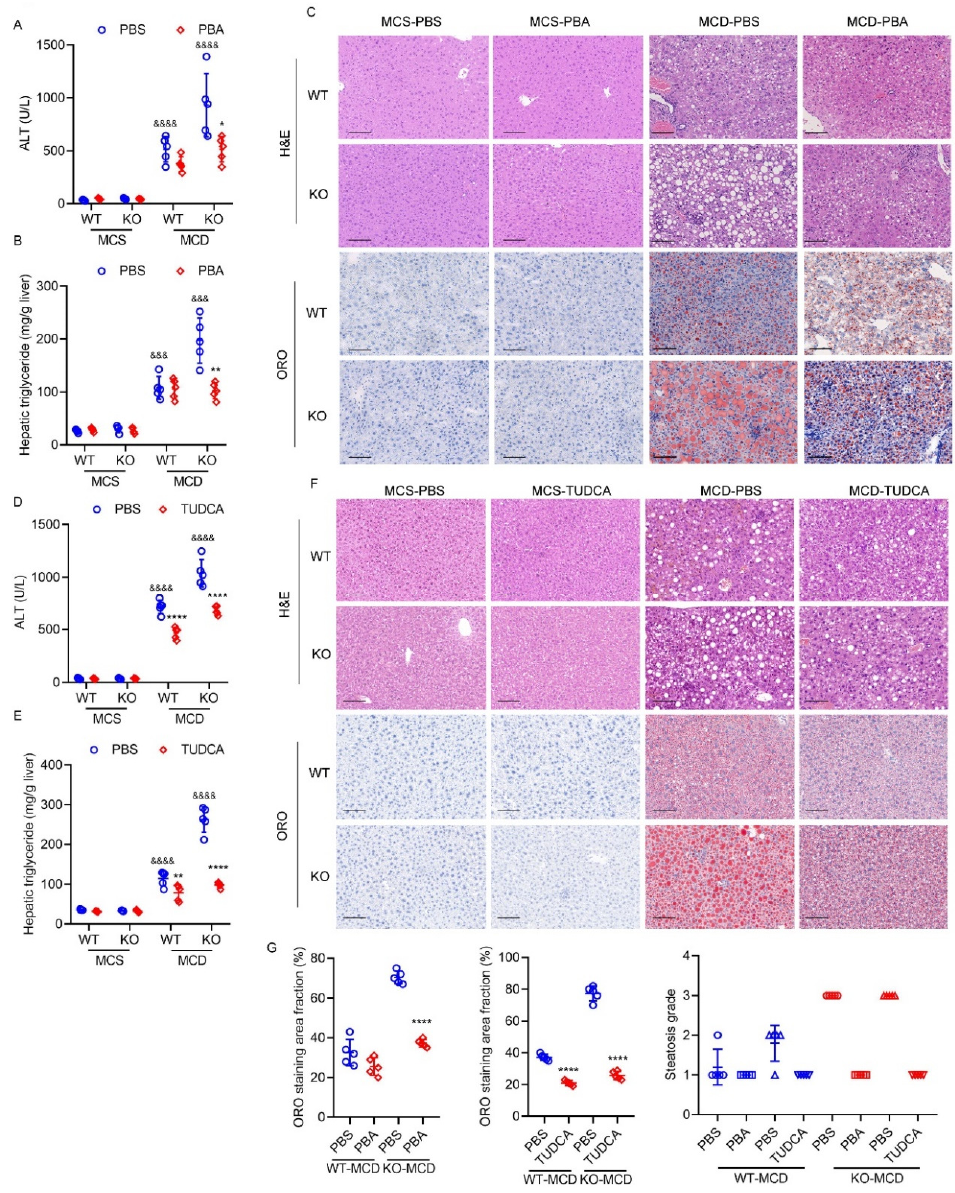
Figure 9. Exacerbated hepatic ER stress contributes to severe steatohepatitis induced by MCD diet in HPS-KO mice. Eight-week-old WT and HPS-KO mice were maintained on an MCD diet for three weeks. Then, the mice were divided into two groups with one group receiving intraperitoneal injection of PBS and another group receiving PBA (100 mg/kg body weight) every three days for